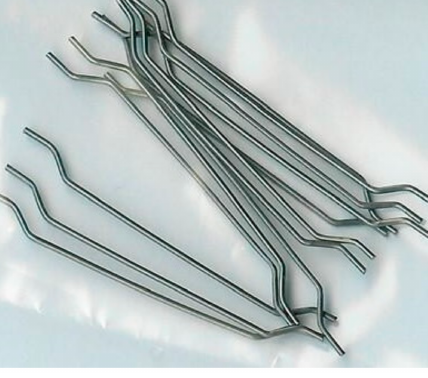
Figure 2. Steel fiber. Table 3. Mixing proportions of materials per cubic